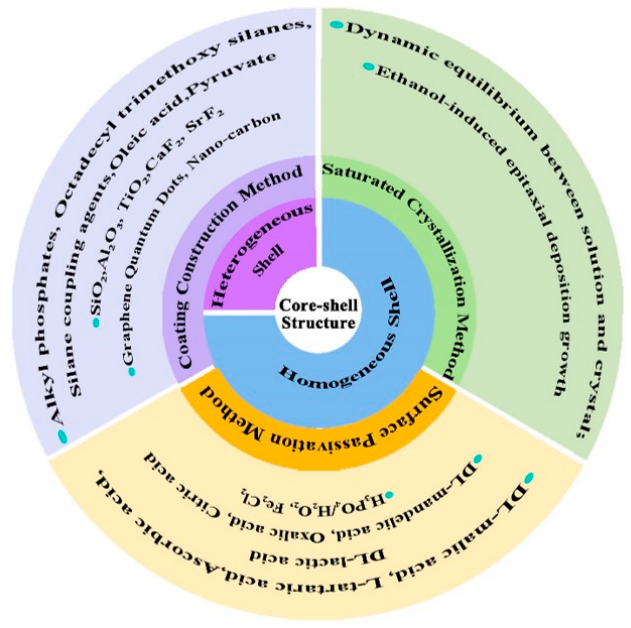
Figure 1. The outline of the classification and synthesis methods of a core–shell structure for A 2 MF 6 : Mn 4+ .